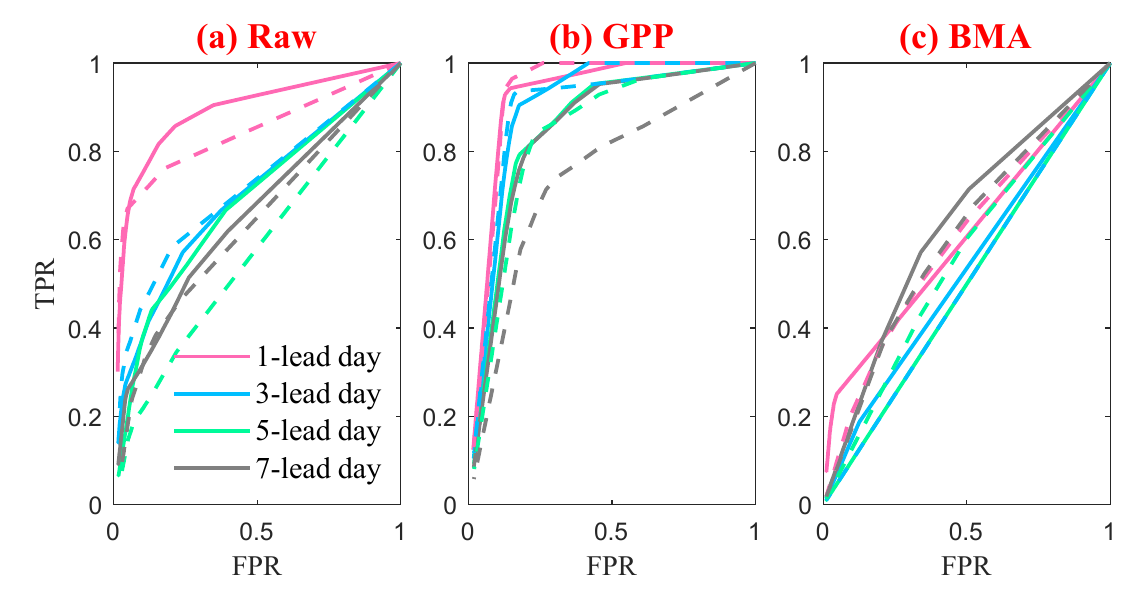
Figure 6. Relative operating characteristic (ROC) curve at 1, 3, 5, and 7lead days for ECMWF (solid line) and NCEP (dash line) for events of precipitation greater than 50 mm (the FPR is the hit rate of no-event “0”, and the TPR is the hit rate of event “1”). In the calculation of ROC, the daily data of 2017 were used.